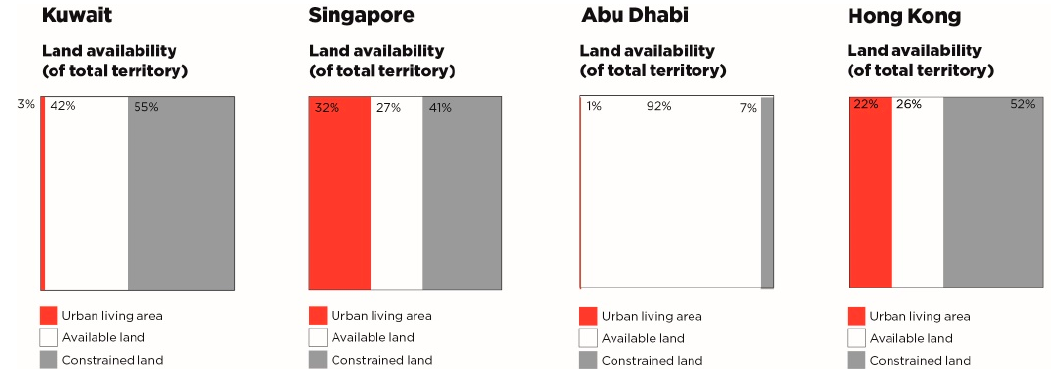
Figure 3. Land availability analysis.